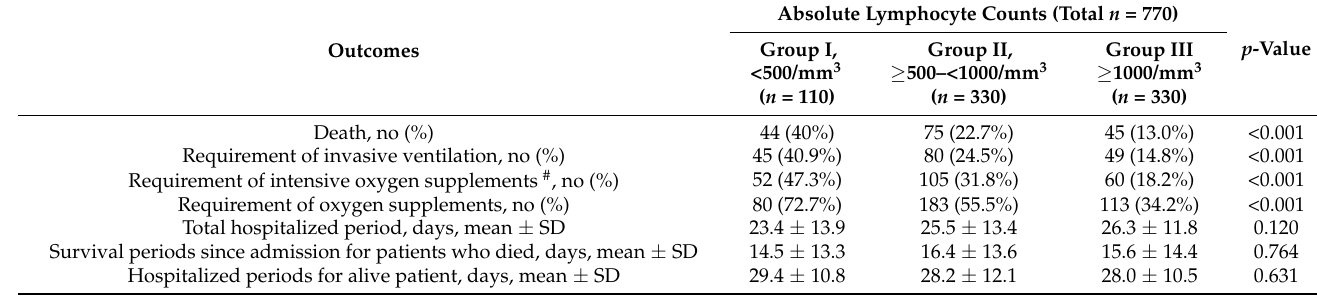
Figure 3. Overall survival outcome according to the lymphopenia groups. Table 3. Comparison of outcomes of COVID-19 among the three